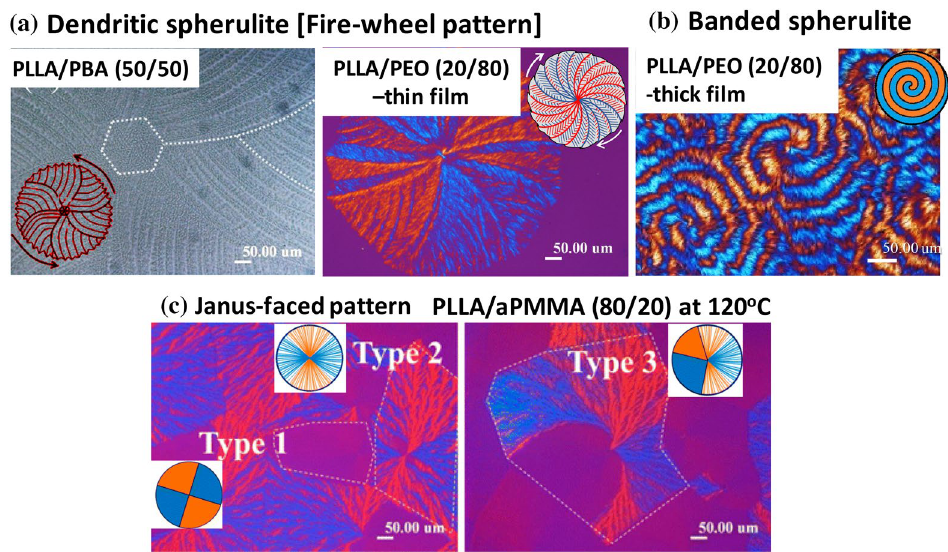
Figure 1. Representative morphologies by crystallization of poly(l-lactic acid) in various PLLA/diluent mixtures: ( a ) Fire-wheel dendritic 14 , ( b ) ring-banded type, reprinted with permission from Ref. 18 , and ( c ) Janus- face composite type (half and half dendritic/ringless) 15 . All images in this scheme are reprinted with copyright permissions from cited